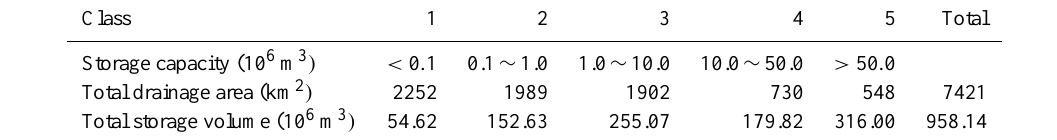
Relationships between Surface Area and Volume of Water Storages